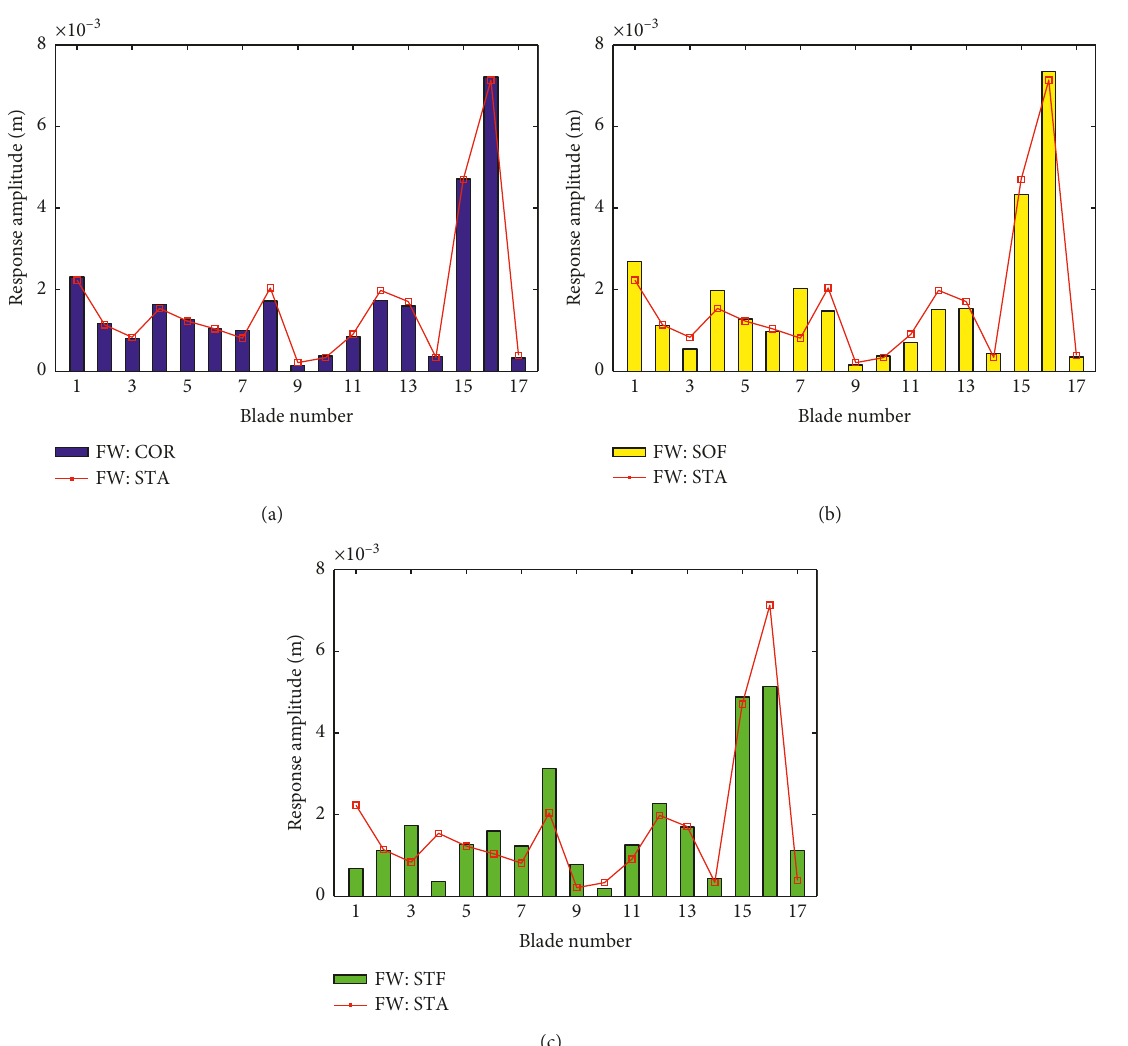
Figure 13: Response amplitudes of blade tips of mistuned bladed disk excited by a 3EO forward traveling wave excitation: (a) case COR, (b) case SOF, and (c) case